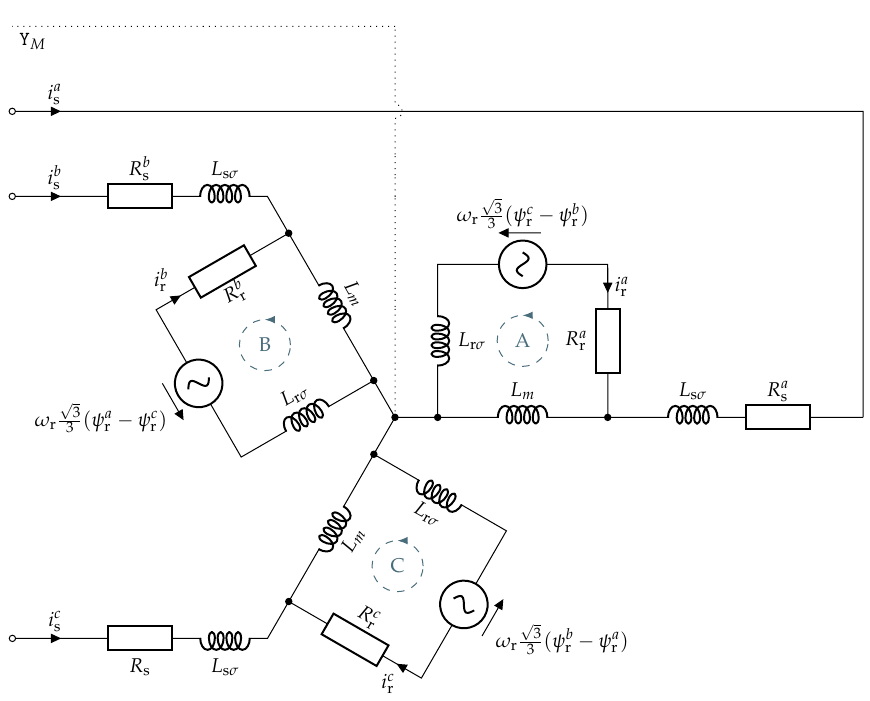
Figure 7. Three-phase equivalent circuit of a squirrel-cage induction